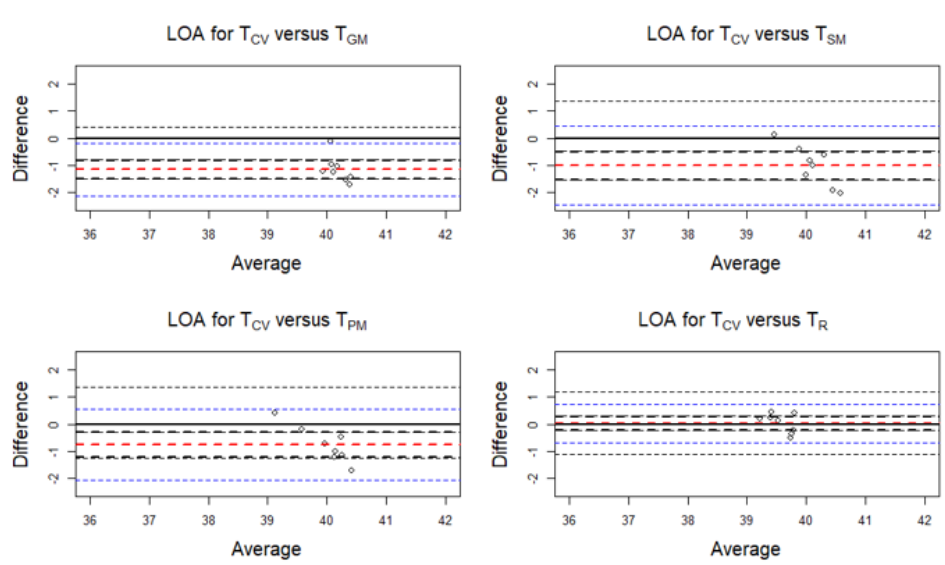
Figure 7. Limits of agreement (LOA) plots for the temperature pairs (T CV / T GM , T CV / T SM , T CV / T PM and T CV / T R ) during Phase D (cool-down walk). The red horizontal dashed line indicates the mean bias. The blue horizontal dashed lines indicate the upper and the lower limit. The black horizontal dashed lines indicate the 95% confidence intervals of the LOA. T CV = central venous temperature, T PM = pectoral muscle temperature, T GM = gluteal muscle temperature, T SM = splenius muscle temperature, T R = rectal